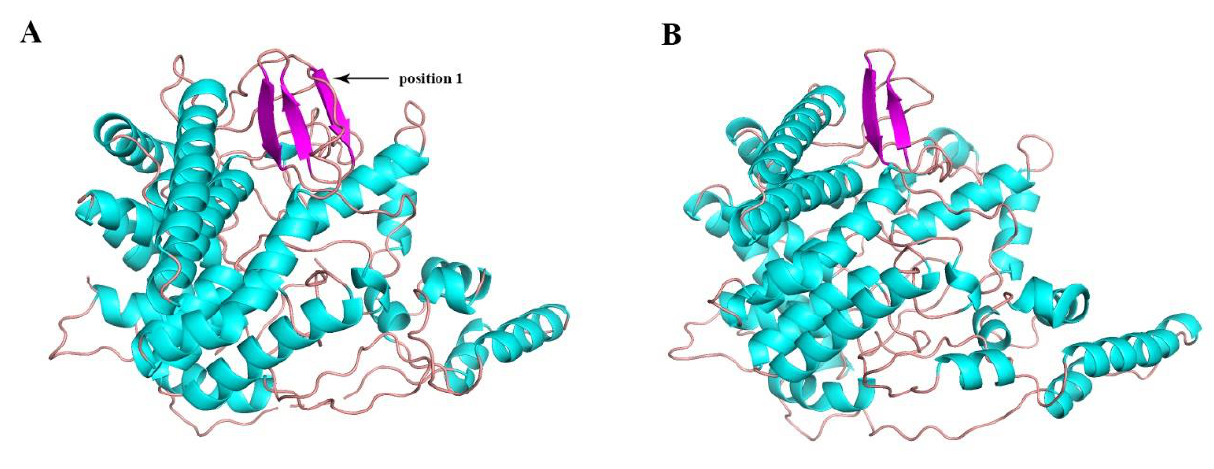
Figure 5. Three-dimensional structure of the E. coli periplasmic trehalase ( A ) and the homology model of the L. oryzophilus trehalase ( B ). The differences between the structures are highlighted with arrows.